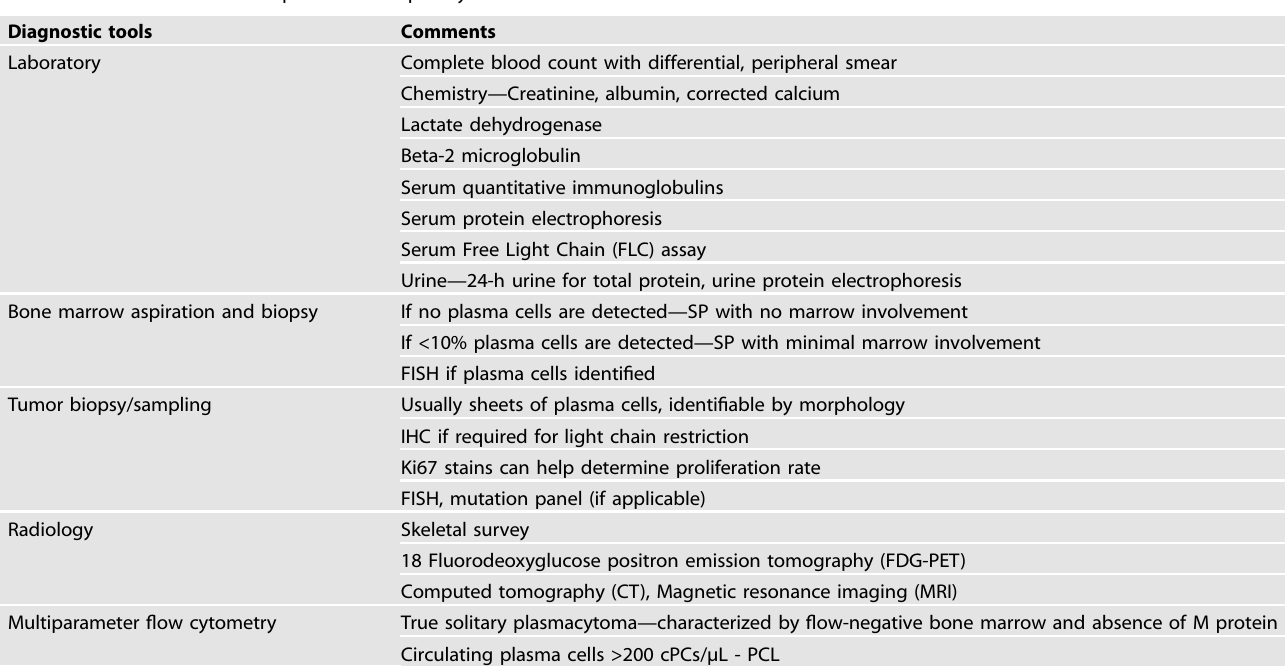
Table 3. Recommended workup for EM multiple